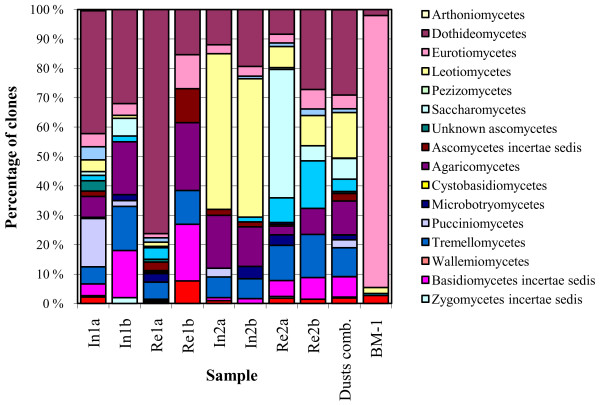
Relative abundances of clones affiliated to fungal classes in the studied dust and building material samples. Sample name abbreviations: In: index building Re: reference building, 1: Location-1, 2: Location-2, a: pre-remediation sample, b: post-remediation sample; Dust comb: combined data from settled dust samples; BM-1: building material pool from Index-1 building. Construction of clone library from the Index-2 building material pool failed.